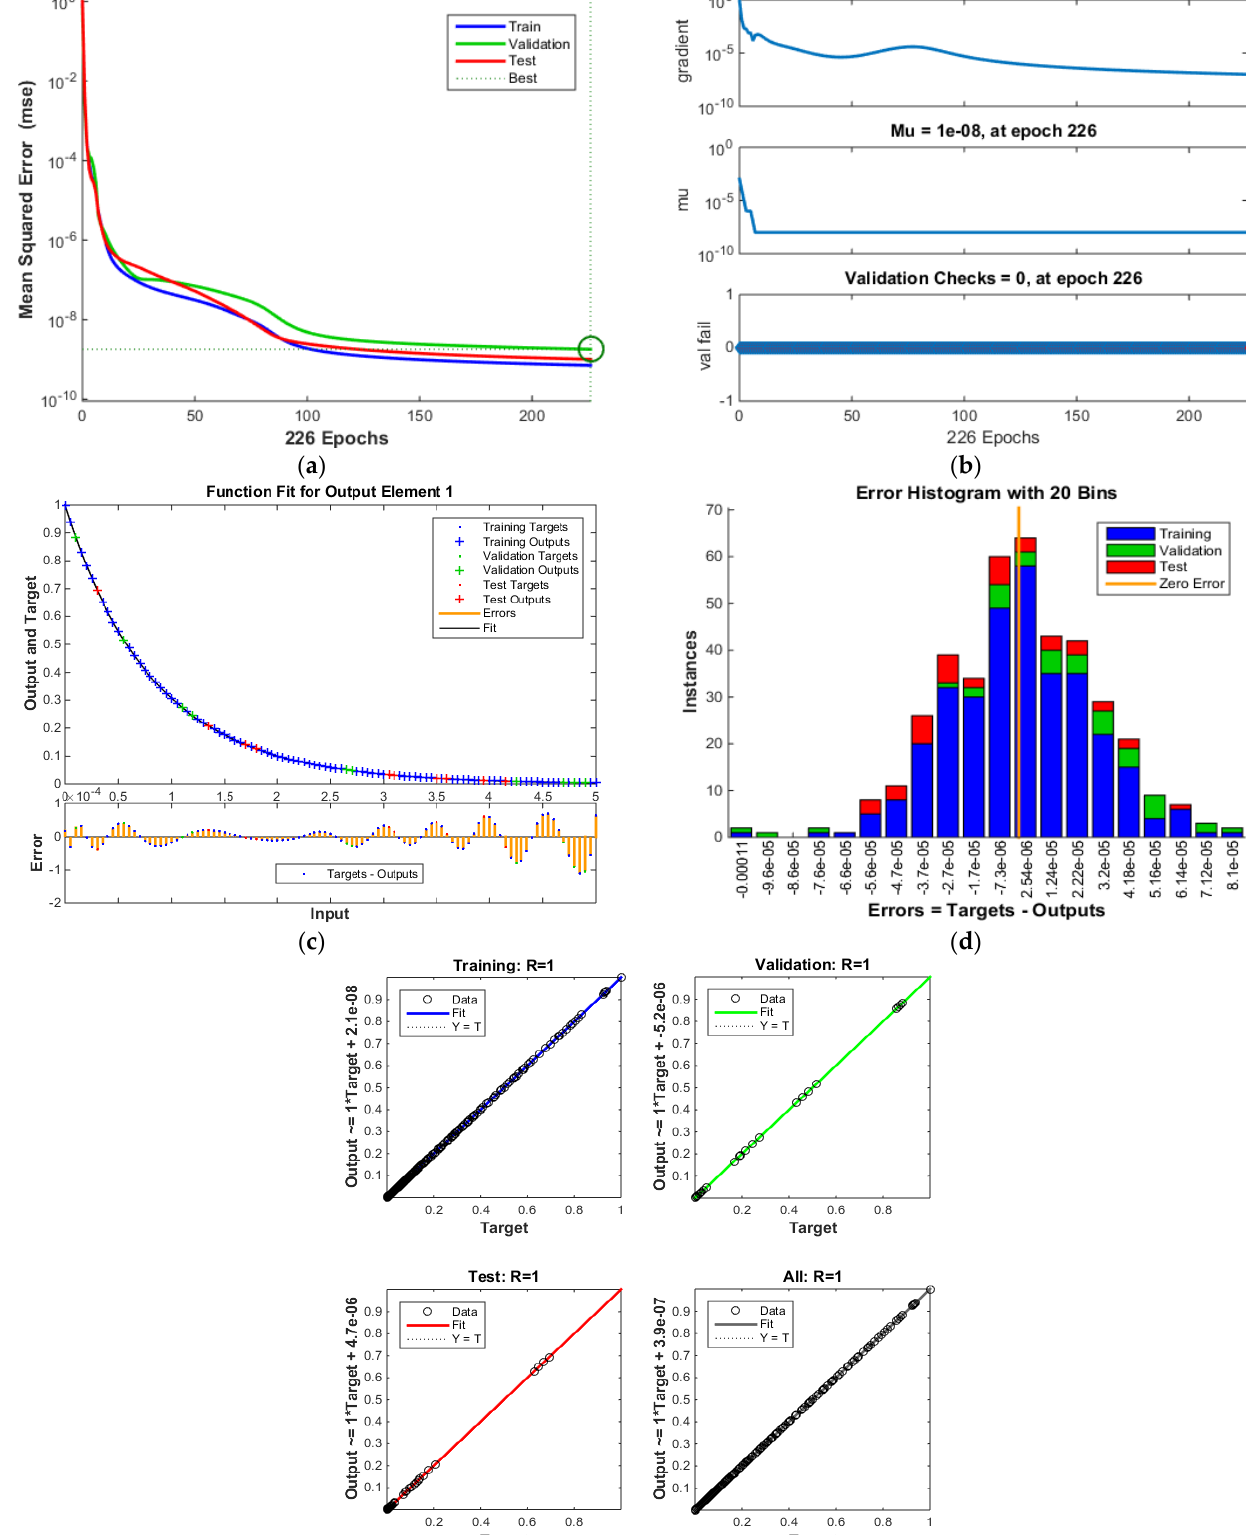
Figure 11. Graphic representation for designed LMT-ABPNN for solving cases of Ma for φ ( η ) of MHD-SGFM. ( a ) MSE Result, ( b ) Results of the transition state, ( c ) Fitness of the curve, ( d ) Histogram for error analysis, ( e ) Regression.